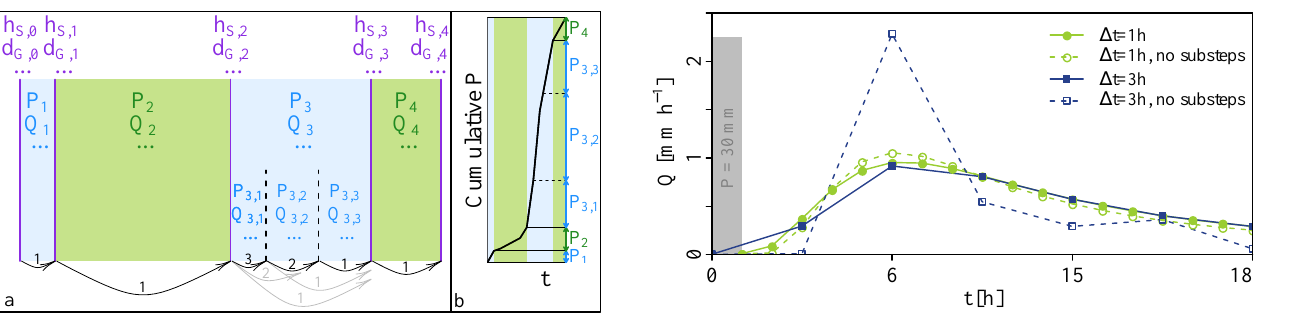
Figure 11. The effect of variable time steps on the model output. An artificial case with a rainfall event of 30mm in the first hour and no evapotranspiration. The lines connect the discharge modelled at the end of a time step (instantaneous value), and do not represent the sum over the time step (which is given in the output file). The same parameter values as in Fig. 5 were